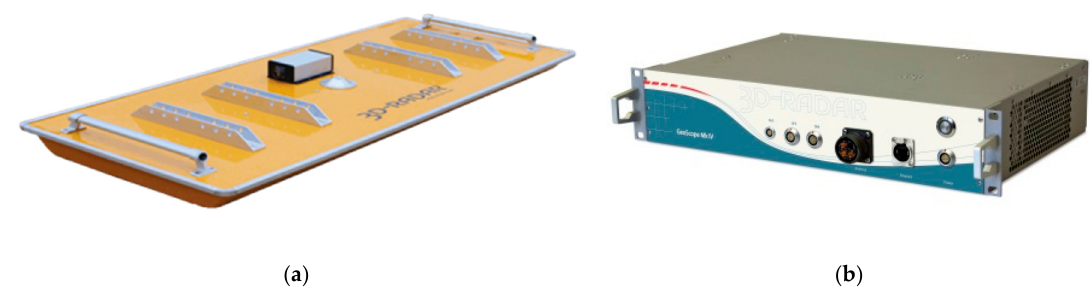
Figure 8. ( a ) Multi-channel GPR and ( b ) data acquisition system.